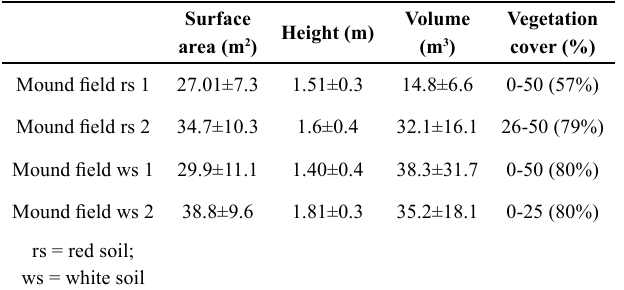
Table 1 . Structure of mounds in mounds fields from Caatinga ecosystem, northeastern